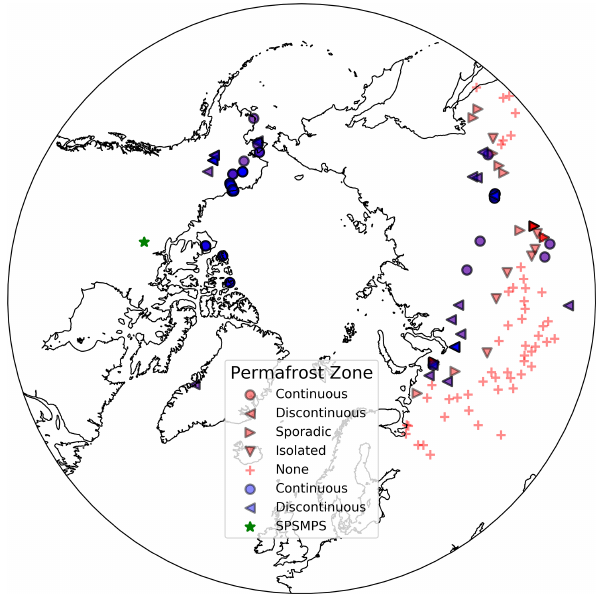
Figure 1. Locations of the 97 GTN-P ALT sites (blue; Table S1), 132 GTN-P borehole observation sites (red; Table S2), and the Slave Province Surficial Materials and Permafrost Study (SPSMPS; green; Lac de Gras, Northwest Territories, Canada) used for model evaluation. Each site is classified according to its permafrost zone listed in the GTN-P. The site markers are semi-transparent; hence, regions with many closely located GTN-P sites will cause overlap, and darkening, of the